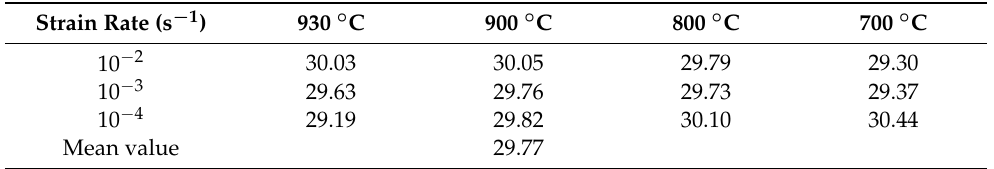
Table 8. Calculation results for the material constants of the constitutive model.